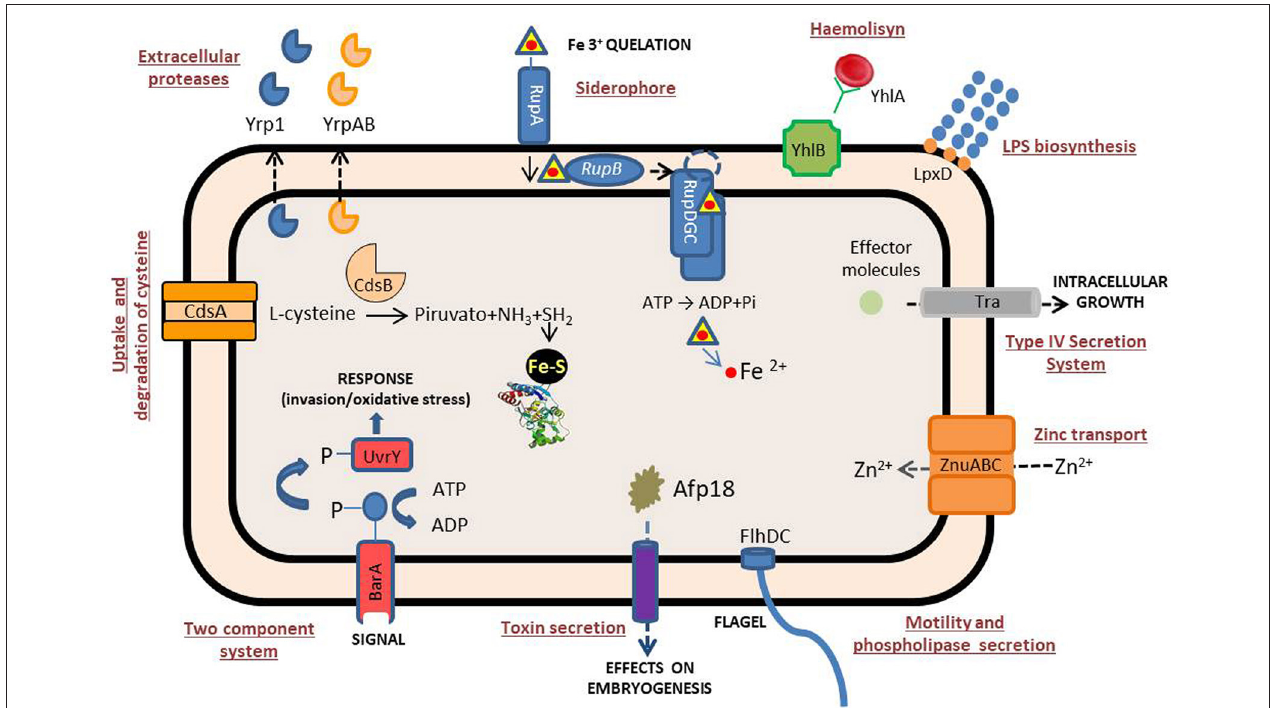
FIGURE 2 | Schematic representation of the Y. ruckeri systems related to virulence. See text for further